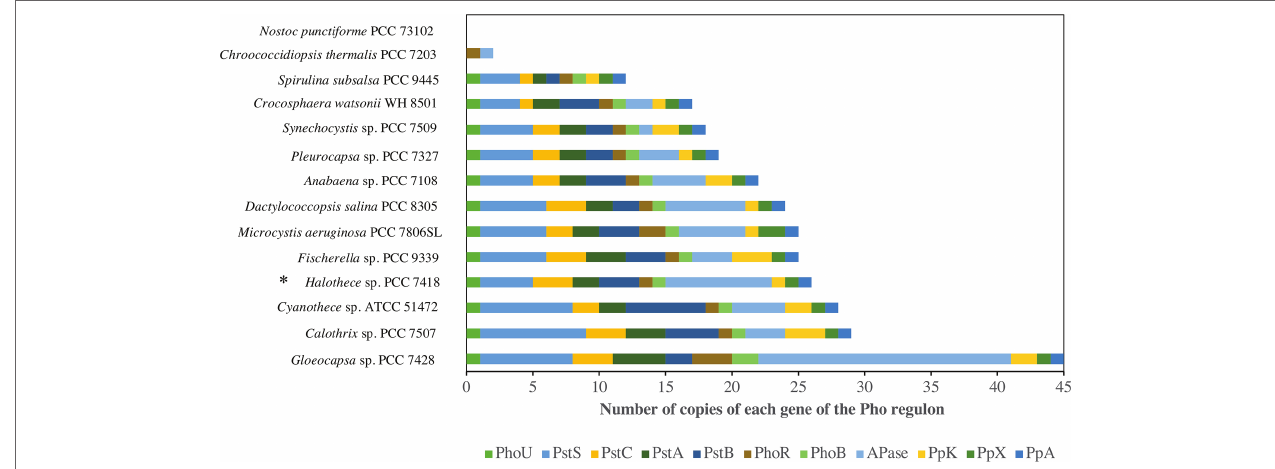
FIGURE 1 | Distribution of the Pho regulon in Halothece sp. PCC 7418 (*) and genomes of its closest cyanobacterial relatives. Annotated genes were identified in